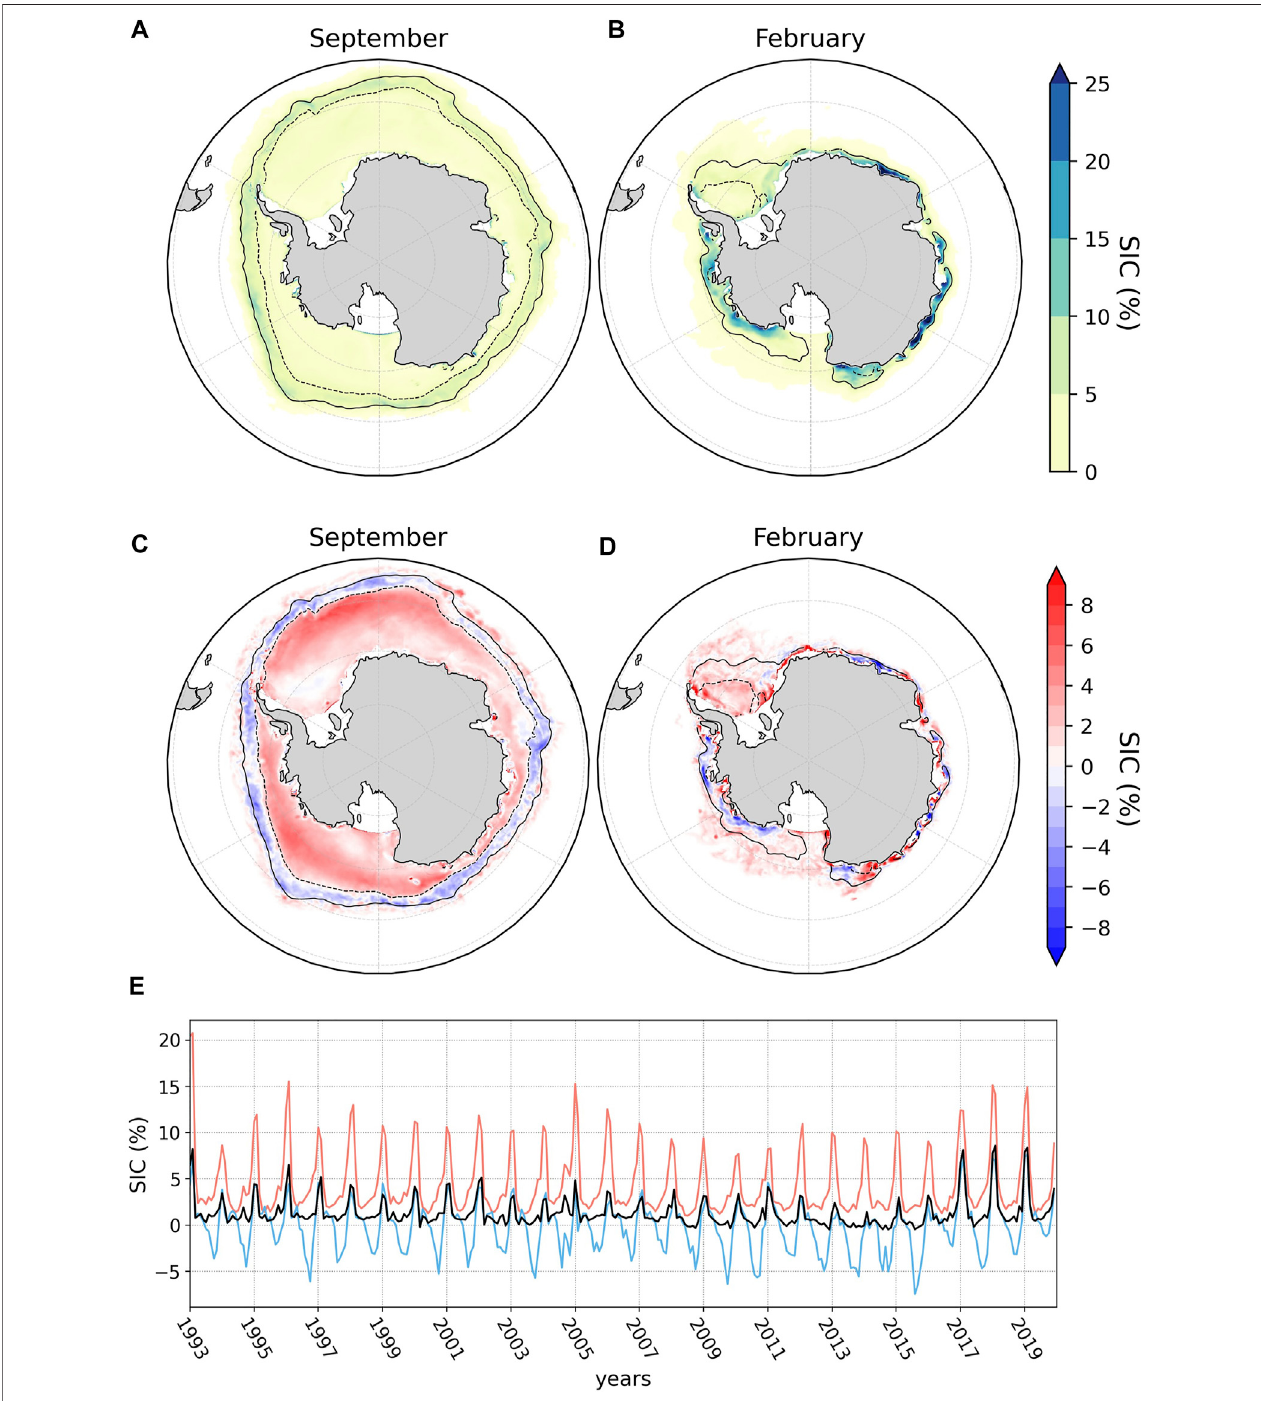
FIGURE 5 | Spatial distribution of (A,B) ensemble spread (ES) and (C,D) difference (in %) between GREP RMSE and ES for SIC in September and February. Contours indicate the mean position of 15% (solid) and 80% (dashed) ice concentration over the period 1993 – 2019 from CDR. (E) Time series of the difference (in %) between GREP RMSE and ES spread of SIC for total area (black), pack ice (red), the MIZ (blue).